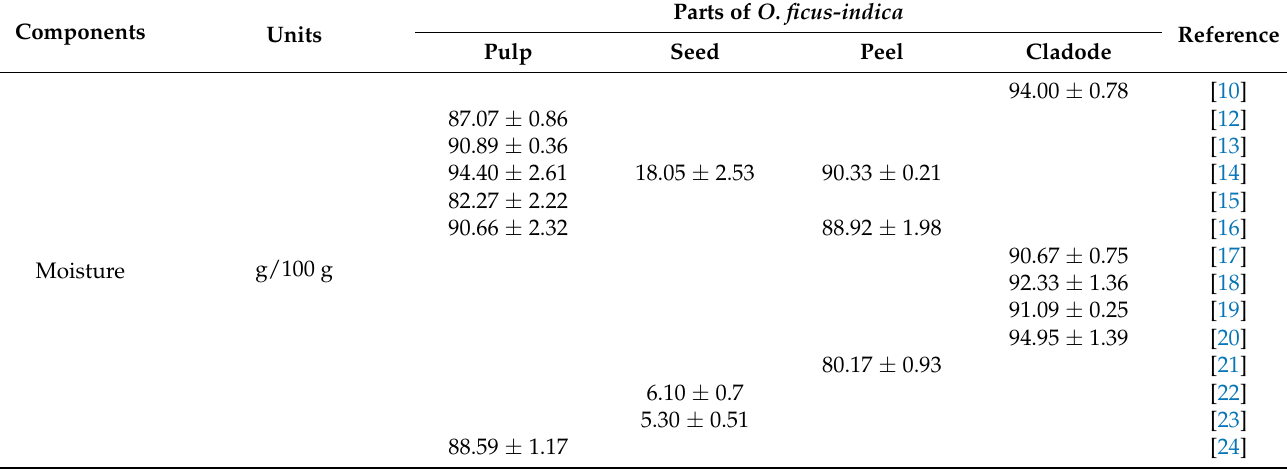
Table 1. Nutritional composition of Opuntia ficus-indica (L.)